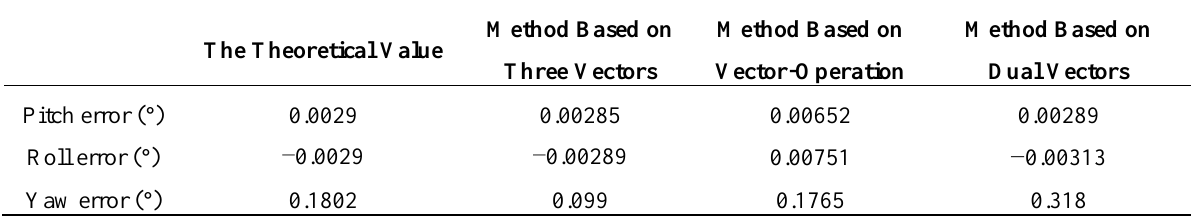
Table 8. The alignment errors in case